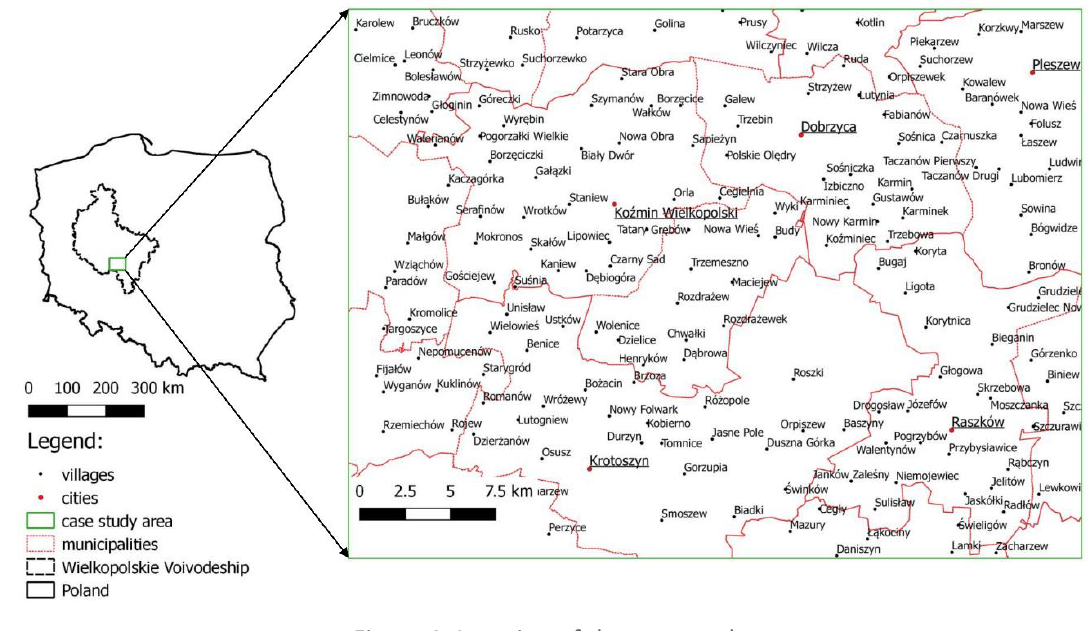
Figure 1: Location of the case